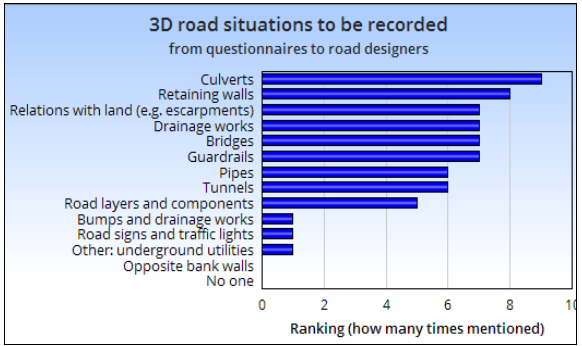
Figure 4: Road Designers’ Priorities for 3D Road Description